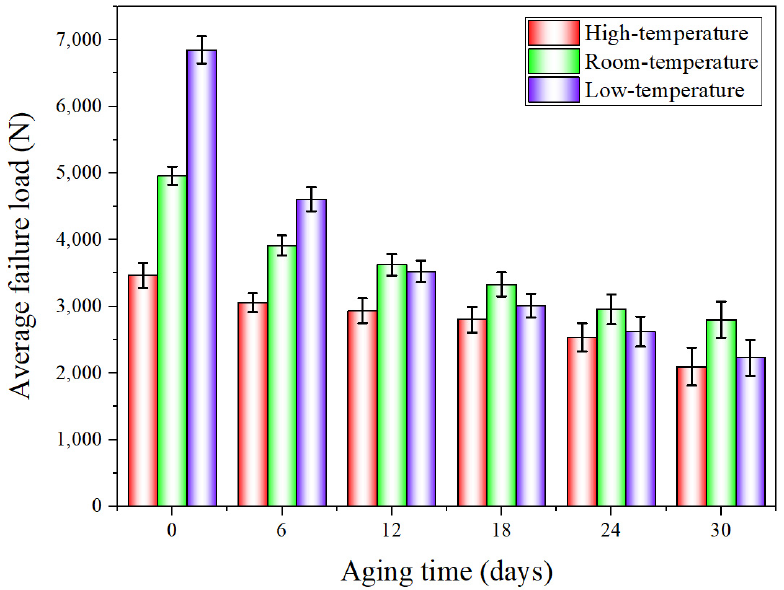
Figure 7. The average failure load of 45° SJs after hygrothermal aging at different temperatures. The average failure loads of BJs are shown in Figure 6. At high temperature, compared with unaged, the failure load decreases by 16.9%, 31.1%, 35.7%, 41.6%, and 44.4% at 6,